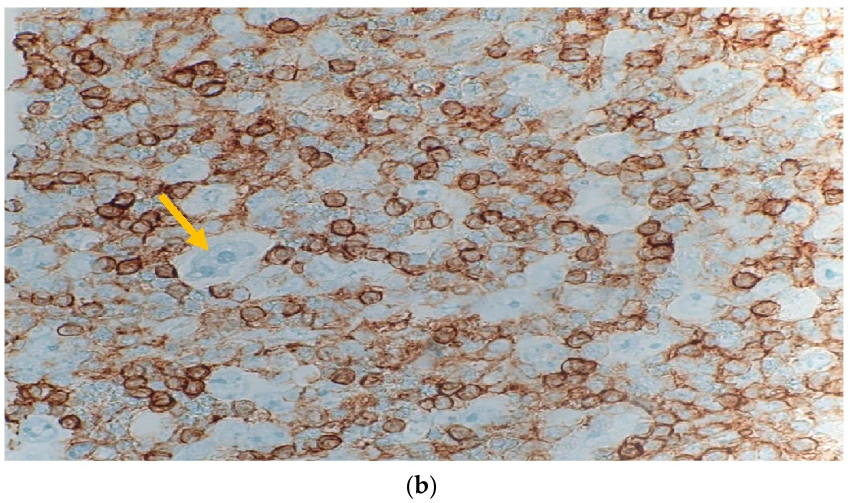
Figure 5. ( a ): Peripheral lymph node magnified (40×) Immunohistochemistry stain with CD30 showing weak nuclear staining (yellow arrows) greater than 10%. ( b ): peripheral lymph node magnified (60×) Immunohistochemistry with CD45 showing a “punched out” pattern with Lacunar cells and Reed-Sternberg cells with negative staining (yellow arrow).